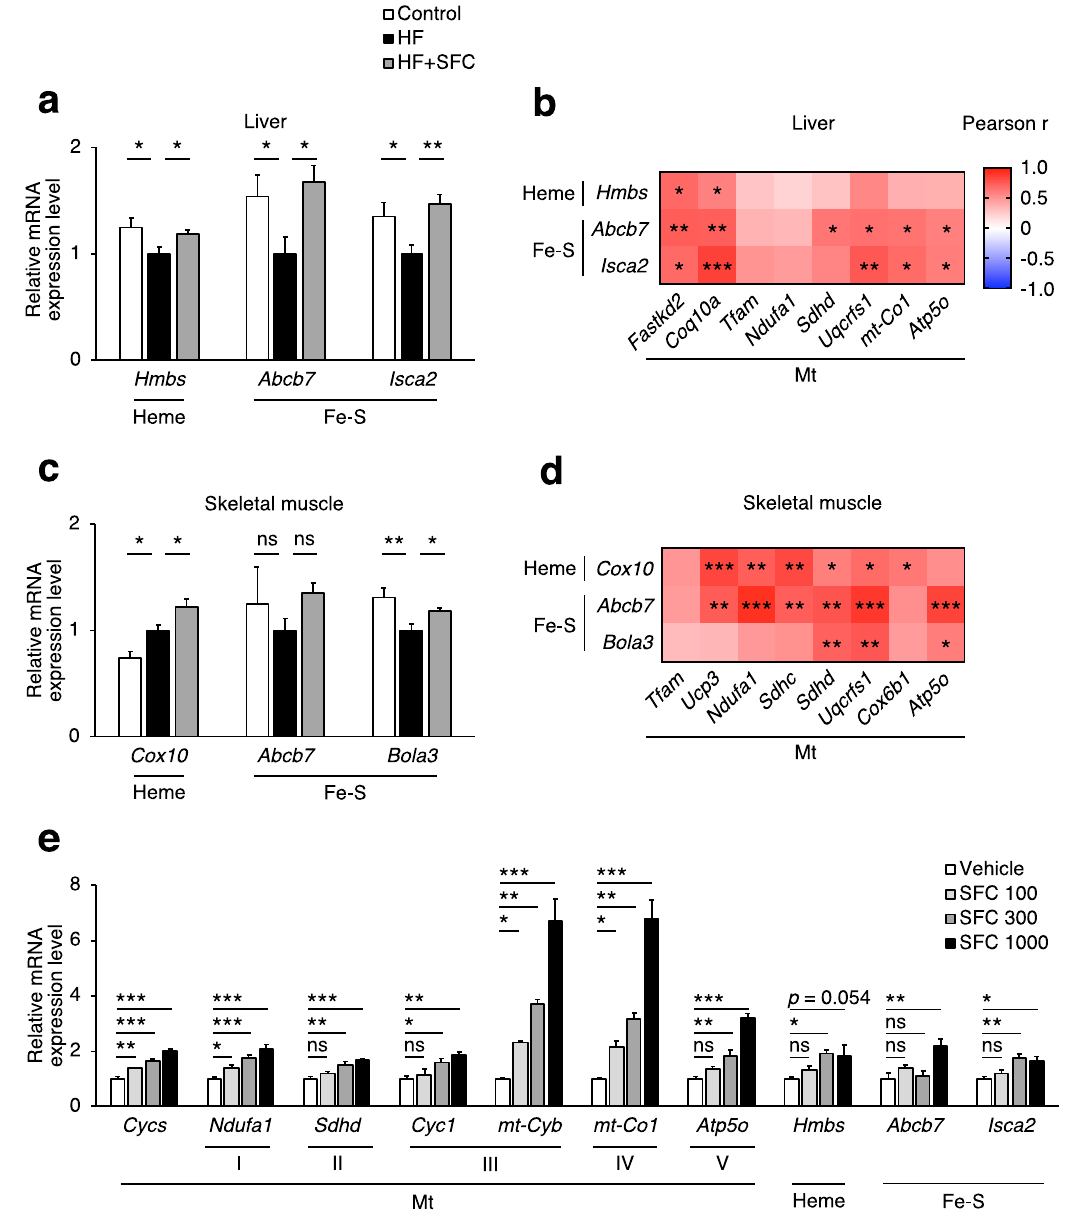
Figure 7. Iron supplementation upregulates the gene expression of iron prosthetic groups synthesis. ( a – d ) Male C57BL/6J mice of 6 weeks of age were fed with each diet for 15 weeks as specified in Fig. 1. ( a , c ) mRNA expression analysis related to the synthesis of heme (Heme) and Fe–S cluster (Fe–S) in ( a ) liver; and ( c ) skeletal muscle ( n = 5–6). Data are expressed as mean ± SEM values. Statistical analysis was performed using a one-way ANOVA followed by Holm–Sidak’s post hoc test. * p < 0.05; ** p < 0.01; ns not significant. (Significant differences vs. HF). ( b , d ) Correlation heatmap between relative mRNA expression levels of mitochondrial (Mt) related genes and Heme or Fe–S related genes in the ( b ) liver; and ( d ) skeletal muscle of HF and HF + SFC ( n = 12). Data were analysed by Pearson correlation coefficient. * p < 0.05; ** p < 0.01; *** p < 0.001. ( e ) Analysis of mRNA expression related to Mt, Heme, and Fe–S from primary hepatocytes isolated from 5-weeks-old male C57BL/6J mice cultured for 24 h ( n = 4). These assay mediums were either supplemented with SFC 100 μM (SFC 100), SFC 300 μM (SFC 300), SFC 1000 μM (SFC 1000), or did not contain any supplements (Vehicle). All media contains 0.05% DMSO. Data are expressed as mean ± SEM values. Statistical analysis was performed via one-way ANOVA followed by Holm-Sidak’s post hoc test. * p < 0.05; ** p < 0.01; *** p < 0.001; ns not significant. (Significant differences vs.